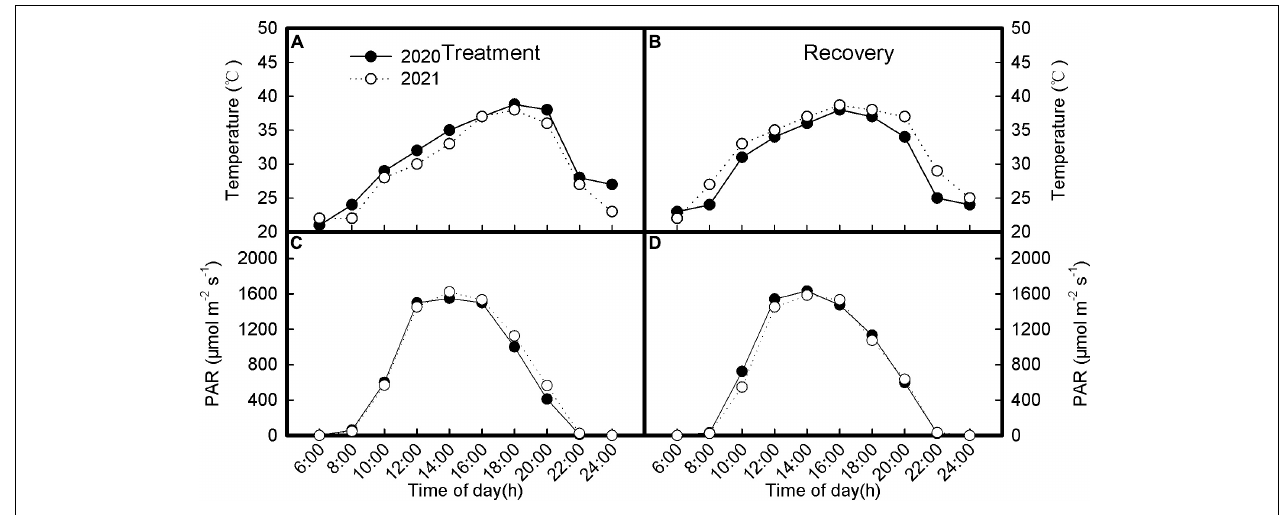
FIGURE 1 | Meteorological data during treatment (A,C) and recovery (B,D) when measuring gas exchange and chlorophyll a